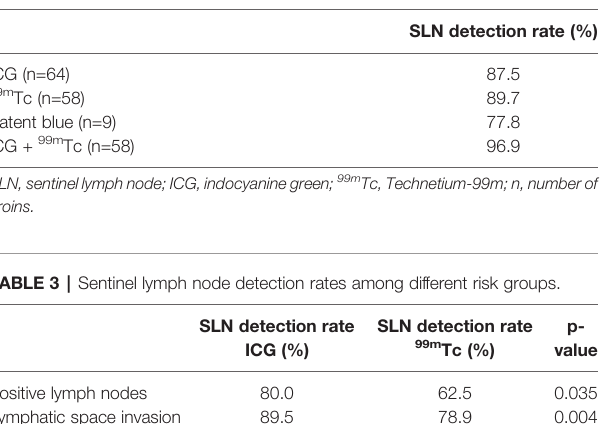
TABLE 2 | Sentinel lymph node detection rates among different sentinel lymph node mapping techniques.